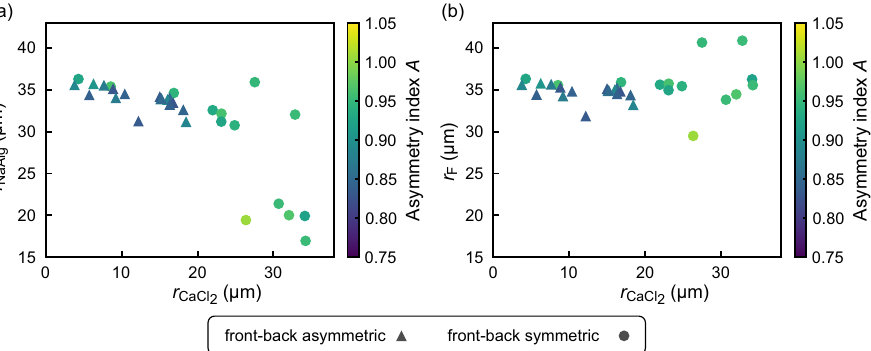
Figure 6. ( a ) Scatter plot of the radii of a NaAlg aqueous droplet r NaAlg and a CaCl 2 emulsion r CaCl measured before fusion. ( b ) Scatter plot of the radii of a fused droplet r F and the corresponding prefused CaCl 2 emulsion r CaCl . The shape of a fused droplet is indicated by circles (front–back 2 symmetric) or triangles (front–back asymmetric). Color code indicates the asymmetry index A . Only the data points for which the droplet fusion occurred are